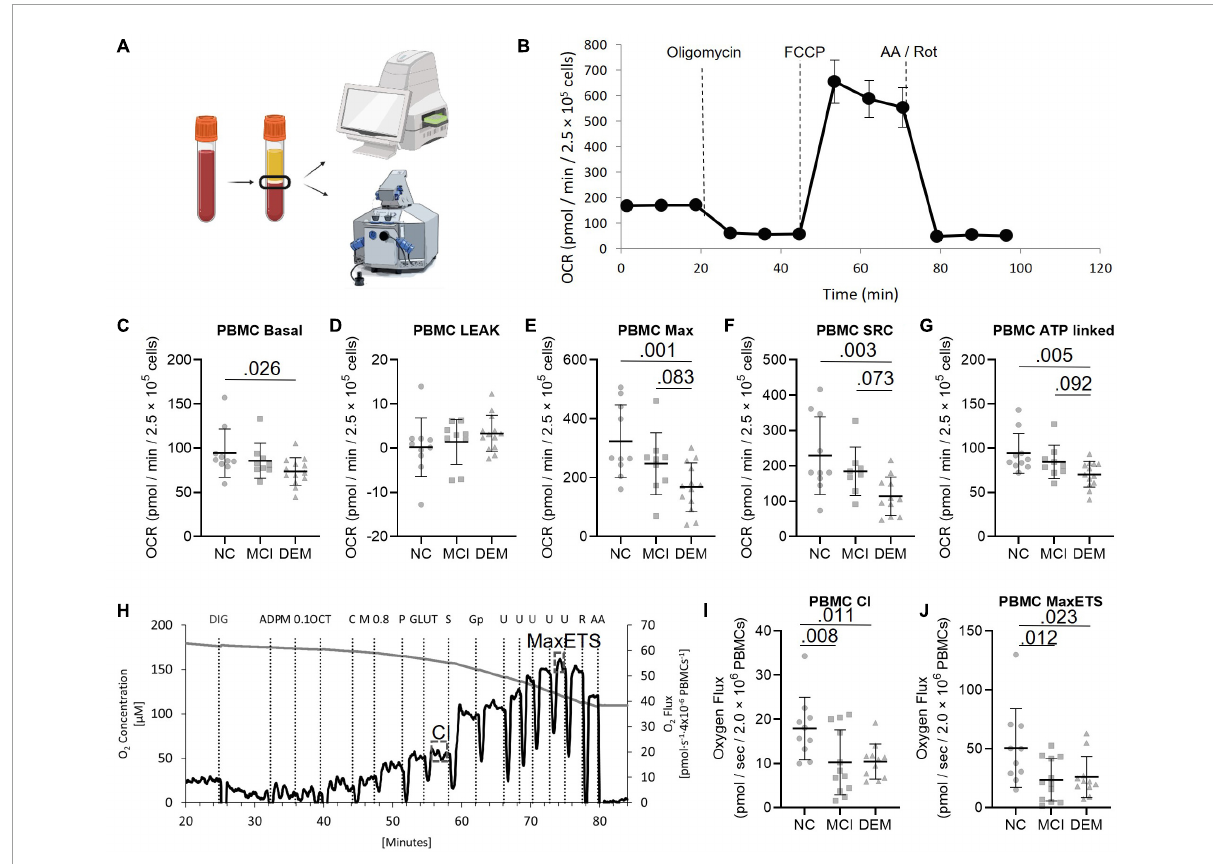
FIGURE1 PBMC bioenergetics from NC, MCI, and DEM participants. (A) Schematic of bioenergetic workflow. (B) Representative Seahorse XF24 e bioenergetics trace. (C–G) Basal, Leak, Max, SRC, and ATP-linked by cognitive status. (H) Representative O2k trace. CI uses saturating concentrations of octanoylcarnitine, malate, pyruvate, and glutamate as substrates. Max ETS is achieved using saturating concentrations of octanoylcarnitine, malate, pyruvate, glutamate, succinate (for complex II), glycerol-3-phosphate (for glycerol-3-phosphate dehydrogenase), and then titrated with FCCP to uncouple respiration to achieve maximal respiration. (I,J) Complex I and MaxETS respiration by cognitive status. Exact P- values